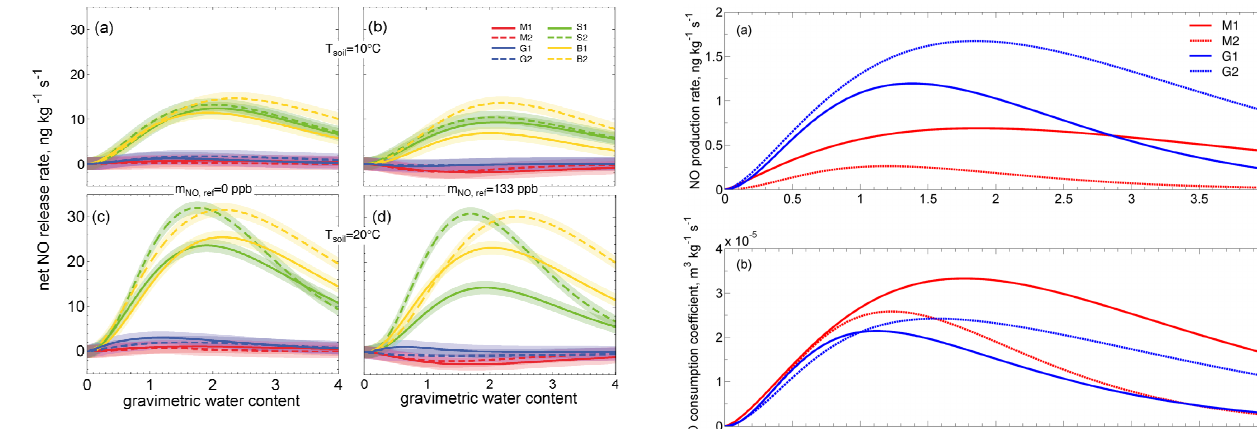
Figure 5. Net NO release rates fitted through experimental results by Eq. (2) (see section 2.4) at (a) T soil =10°C and m NO,ref =0 ppb, (b) T soil =10°C and m NO,ref =133 ppb, (c) T soil =20°C and m NO,ref =0 ppb NO and (d) T soil =20°C and m NO,ref =133 ppb (all expressed in terms of mass of nitrogen). The transparent bands are the prediction bands of each line (95% confidence level).